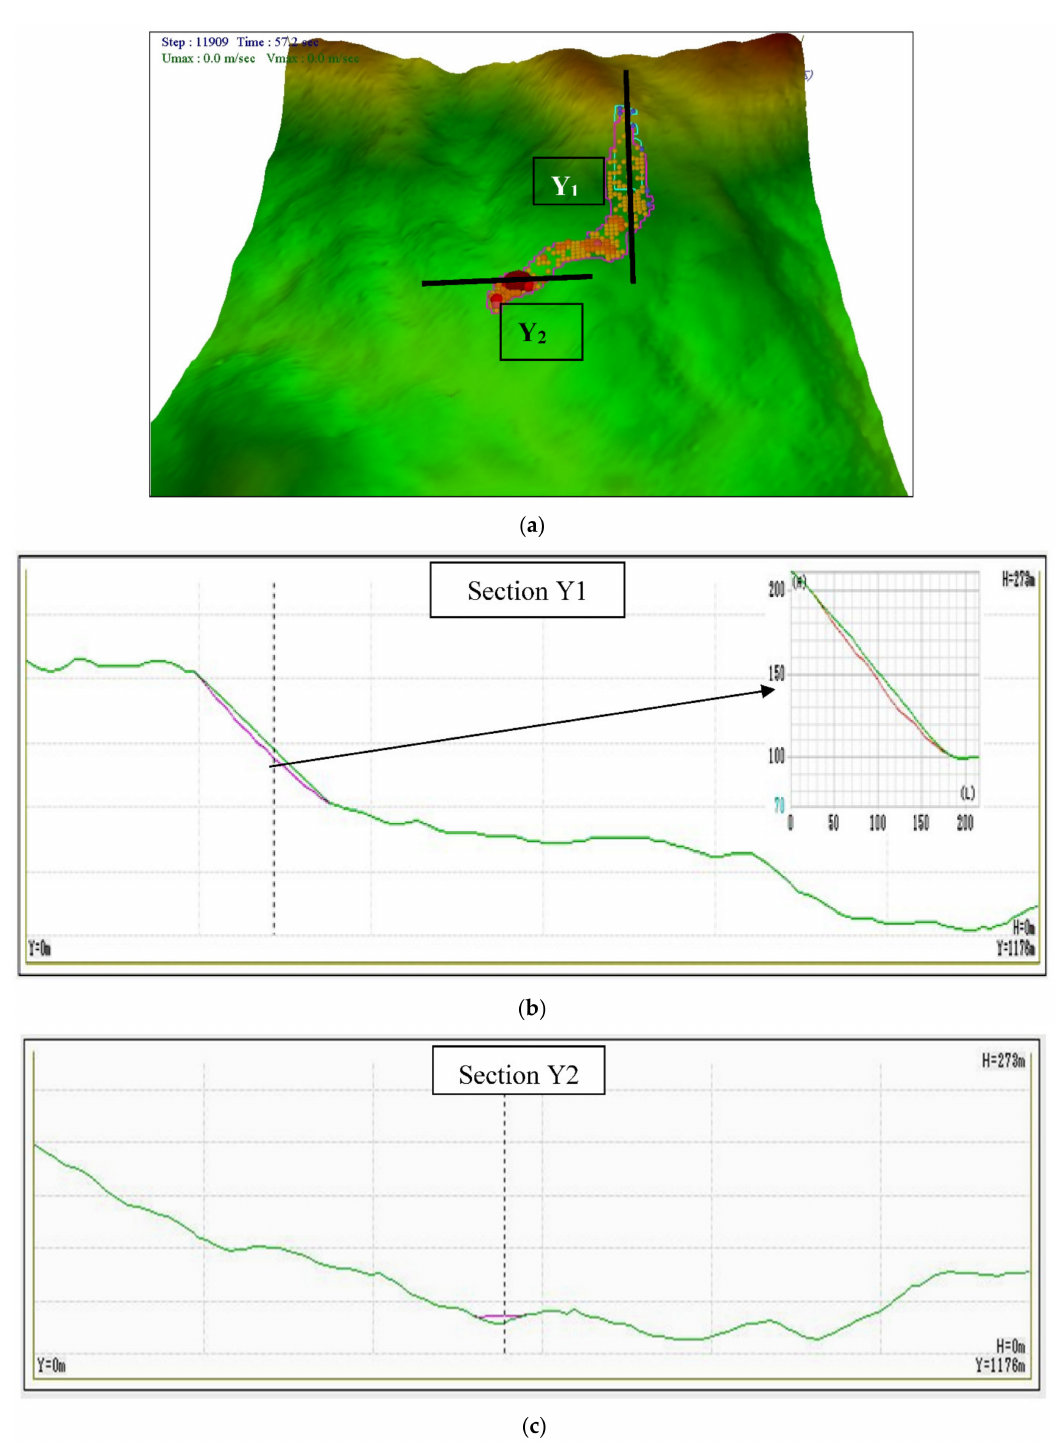
Figure 16. Simulated landslide topography: ( a ) view of landslide runout; ( b ) longitudinal section profile along Y1; ( c ) longitudinal section profile along